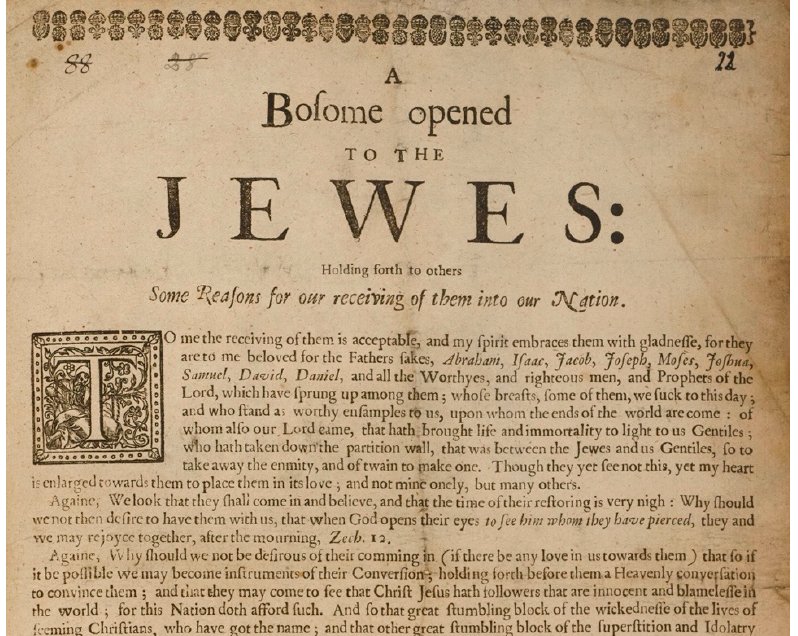
Figure 37. A Bosome Opened to the Jewes; Marsh’s Library Z.2.1.6.22.